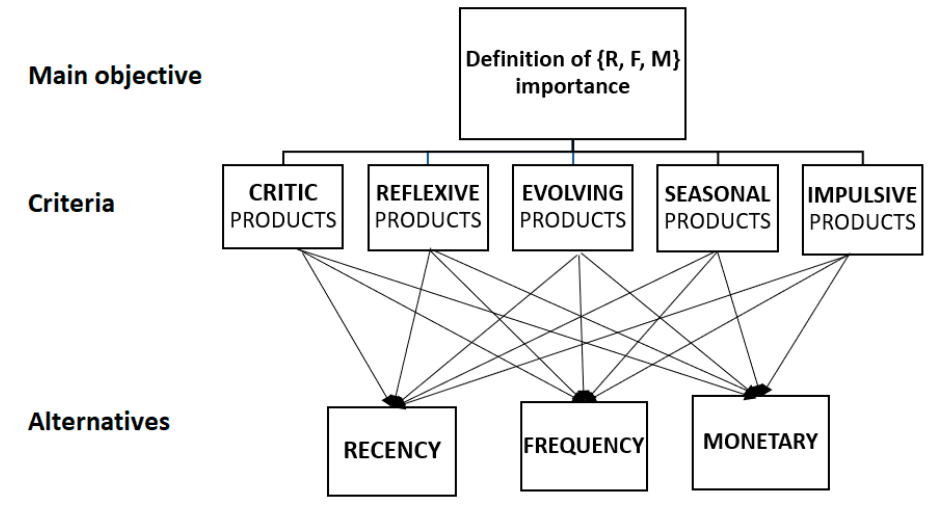
Figure 9. AHP model.